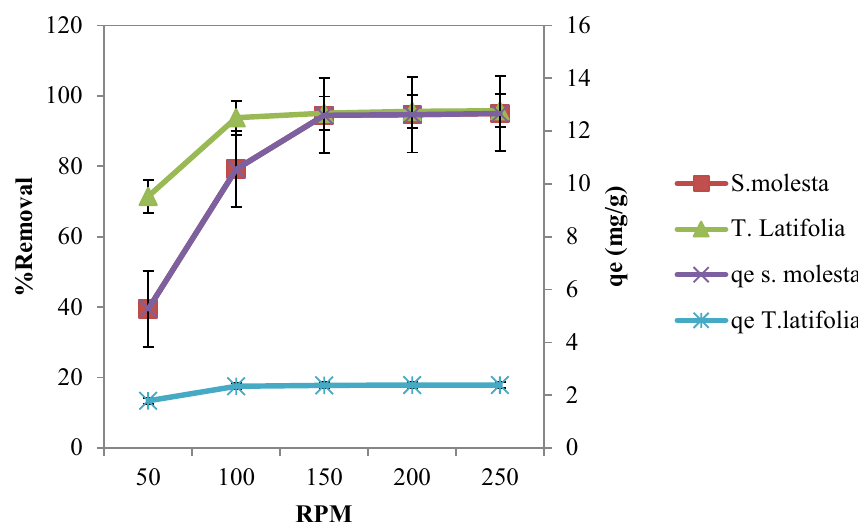
Fig. 8 Effect of agitation speed (rpm) on Cr 6+ adsorption by S. molesta and T.